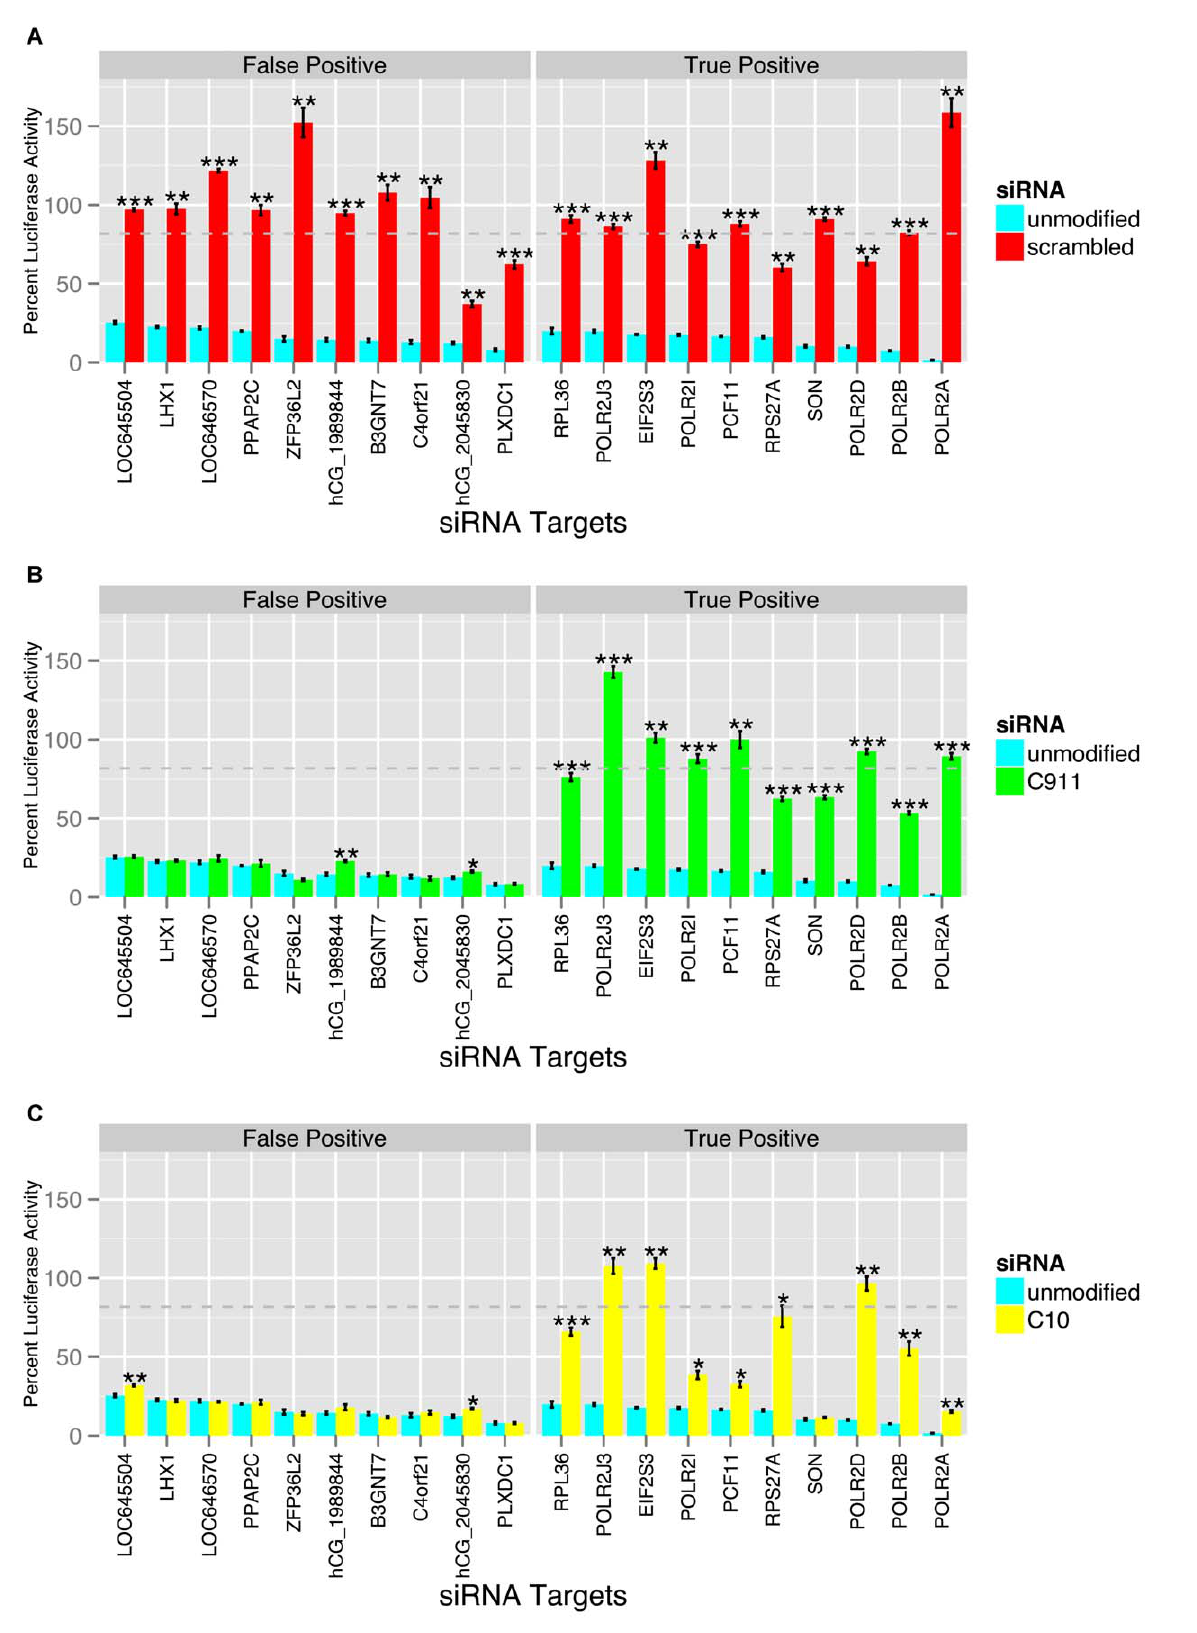
Figure 3. Results for three different classes of negative control. siRNAs which downregulate a luciferase reporter more than two-fold ( teal, panels A,B, and C ) were selected and categorized as either true or false positives based on biological annotation, the activity of other siRNAs